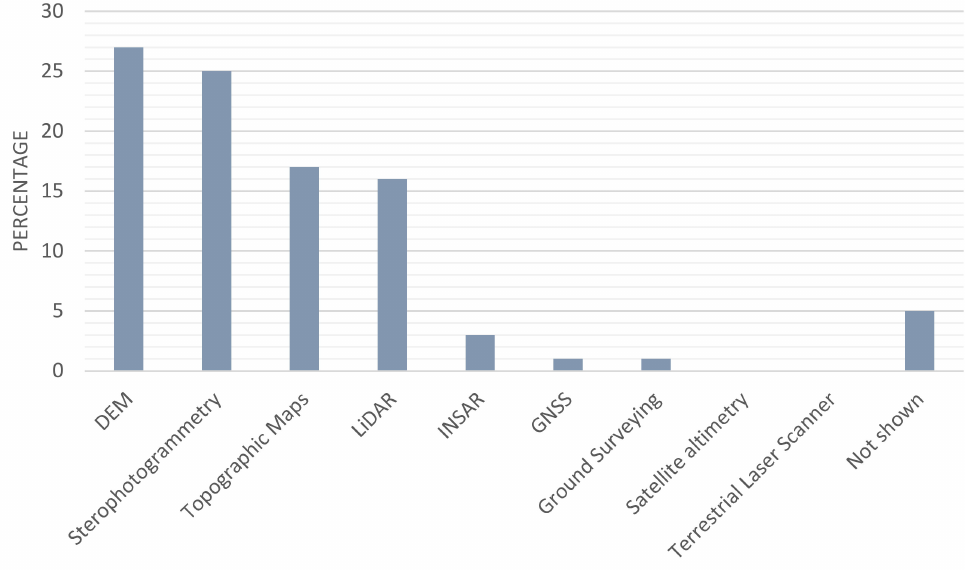
Figure 2. Percentage distribution of DEMs (Digital Elevation Models)